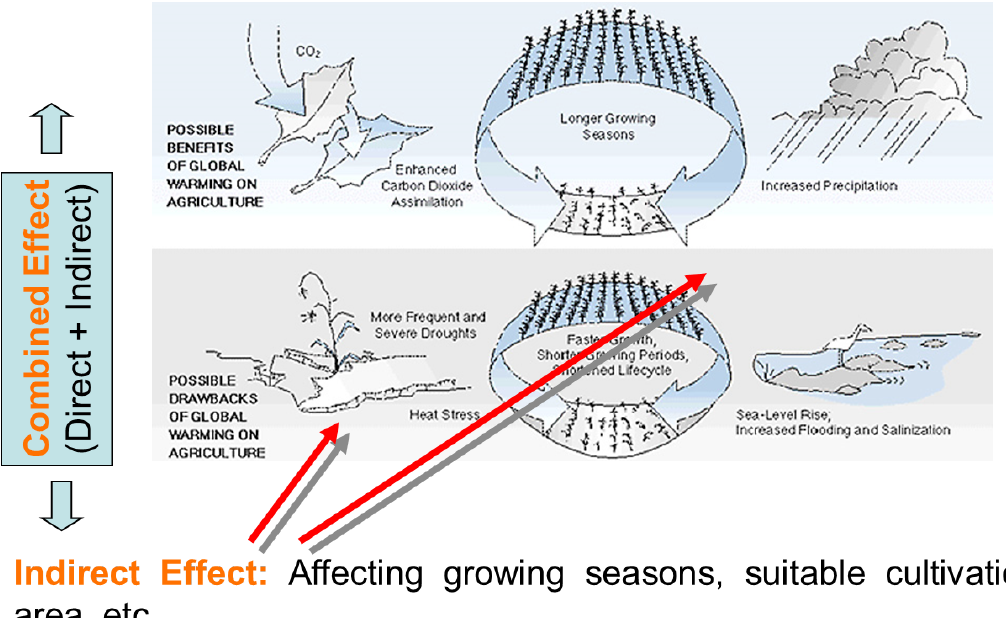
Figure 3: Effects of climate change on crops (source: M. Bindi, University of Florence,